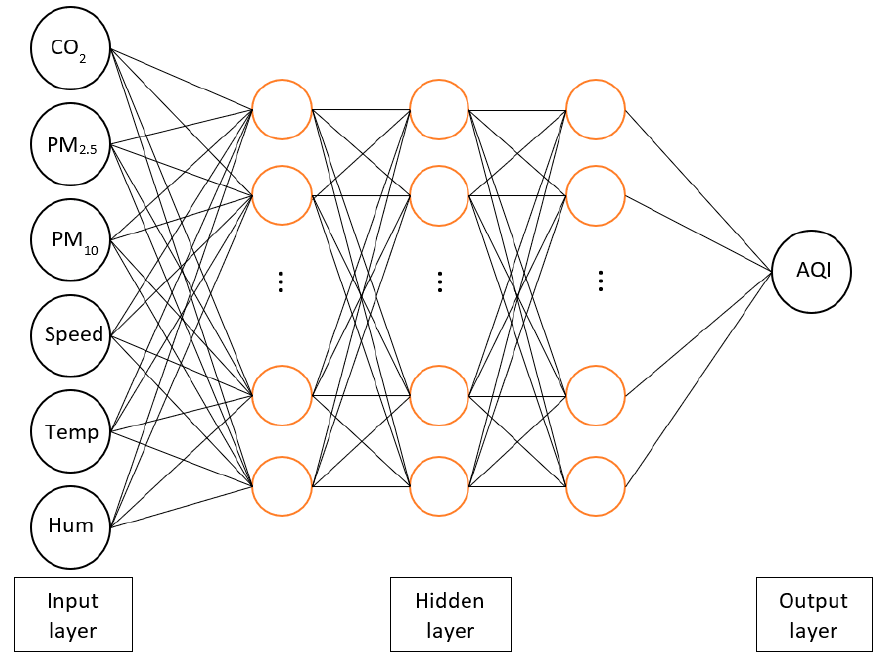
Figure 8. The MLP structure with various hidden node numbers.